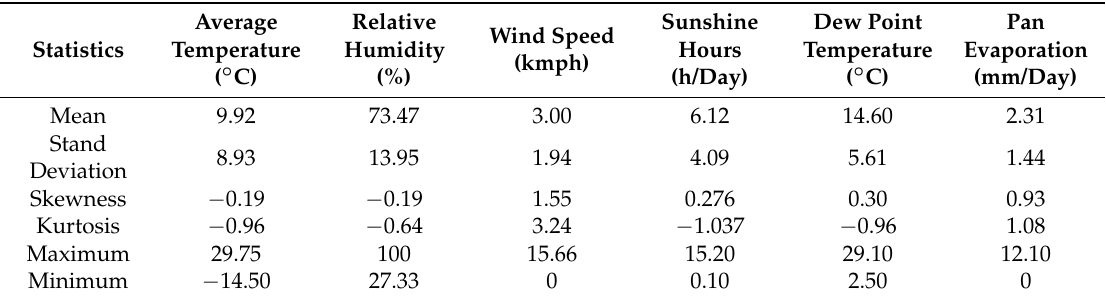
Table 1. Statistical analysis of meteorological parameters at